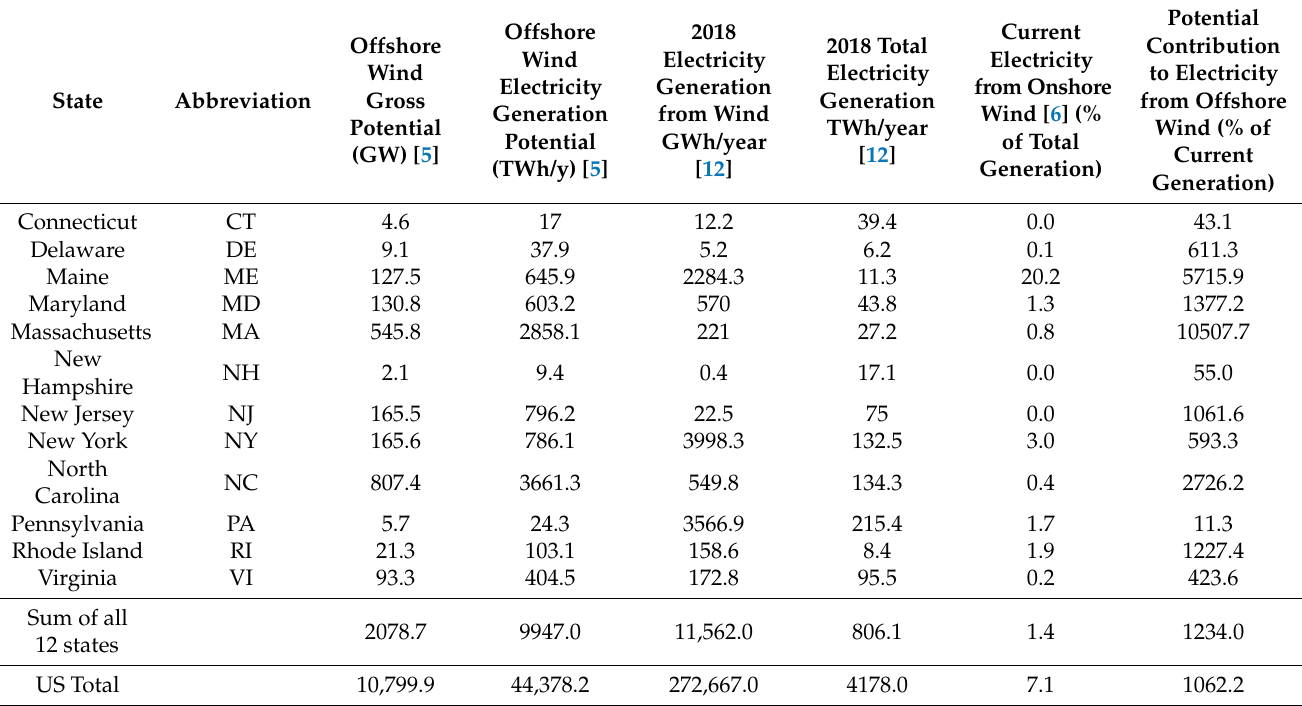
Table 1. Offshore wind energy potential of U.S. east coast states that have offshore wind lease areas (LA); Connecticut, Delaware, Massachusetts, Maryland, Maine, New Hampshire, New Jersey, New York, North Carolina, Pennsylvania, Rhode Island and